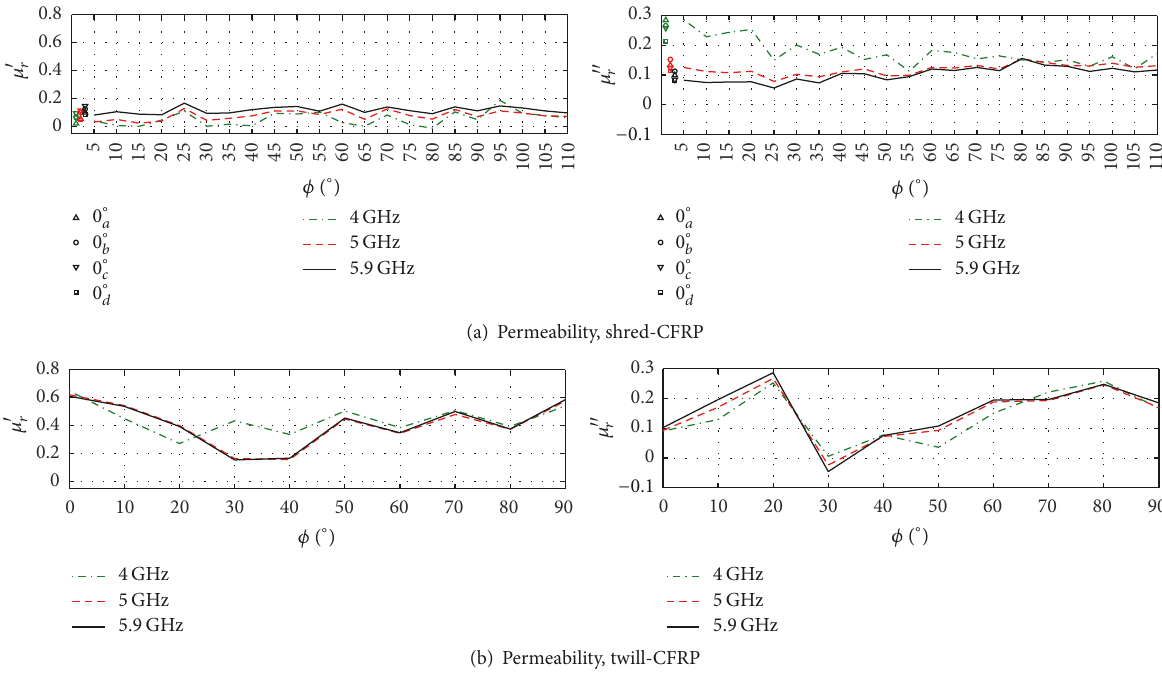
Figure 5: Permeability of (a) shred-CFRP and (b) twill-CFRP dependent on the orientation of the cut sample.